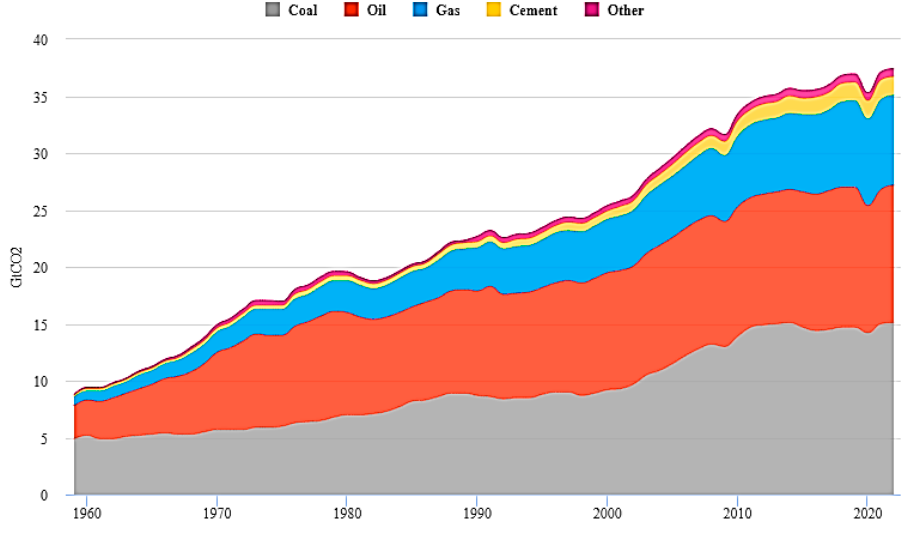
Figure 2. Annual CO 2 emissions from different types of fuels [14–16].